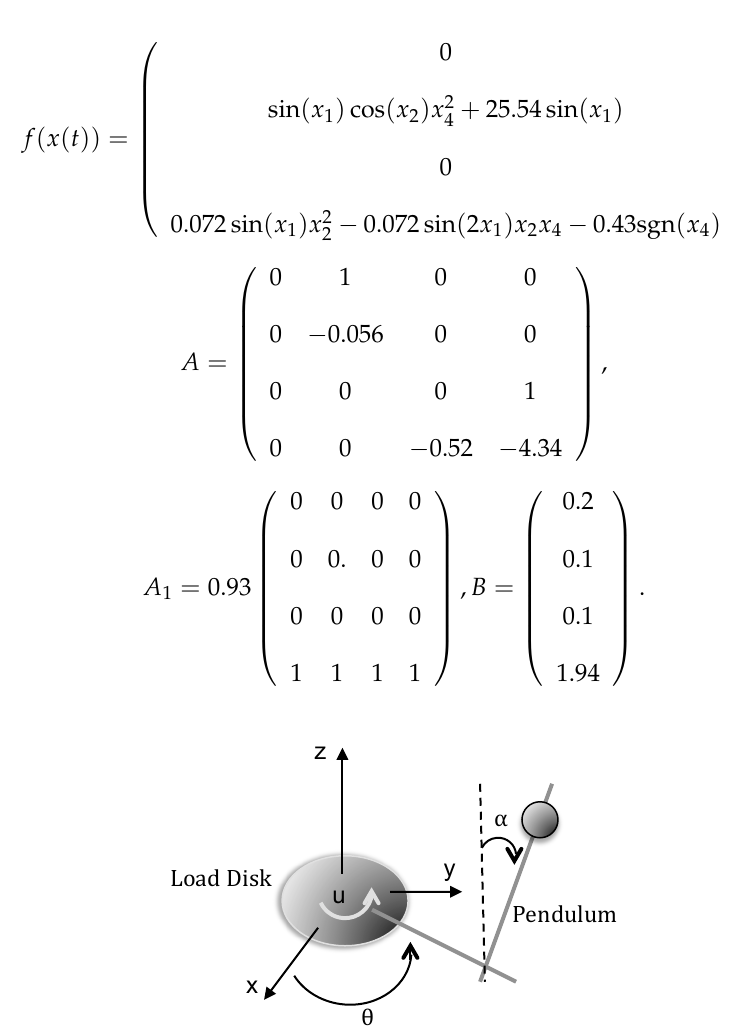
Figure 3. Diagram representation of Furuta pendulum with rotating base [50,51]: θ load disk angular position, α pendulum angle, u motor